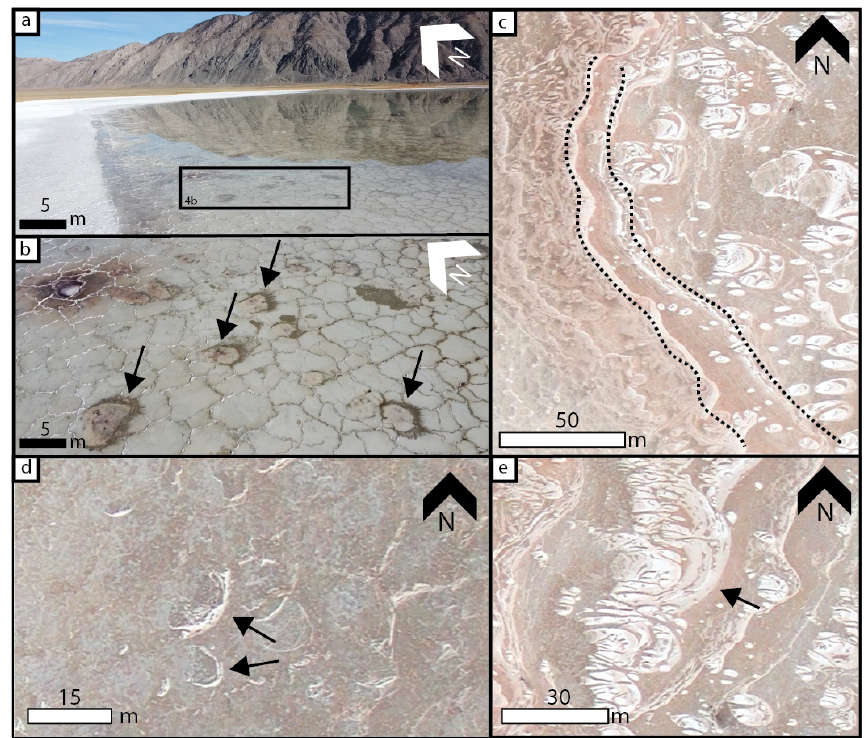
Figure 3. Crescent features observed in Deep Springs. (a, b) Dark-toned crescent features captured in drone footage in January 2021. Features appear to be concentrated around the exposed mudcracks and are all oriented towards the west, aligning with the orientations observed in a satellite image in 2013. (c) Satellite image from 2013 showing an abundance of light-toned crescent-shaped features oriented towards the west. These features, like those captured by the drone in (a) and (b) , are concentrated along the western edge of Deep Springs Lake. Banded shoreline of Deep Springs Lake is indicated by the bounding dashed black lines. (d) Open-ended crescent features, indicated by black arrows, oriented in same direction. (e) Linked crescents (indicated by black arrow) near the shoreline of Deep Springs Lake. Images (c) and (d) courtesy of Google Earth (© Google Earth